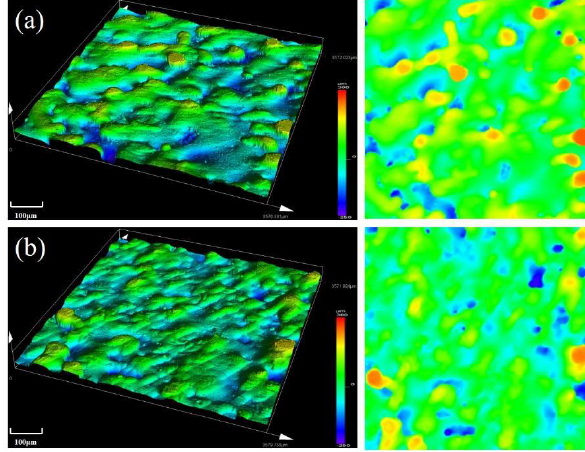
Figure 15. Surface topography of the SLM alloy formed at different scanning speeds: ( a ) 1000 mm/s and ( b ) 700 mm/s.